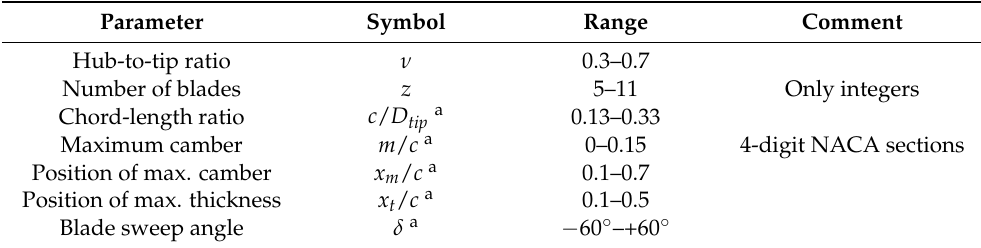
Table 1. Geometrical parameters varied.